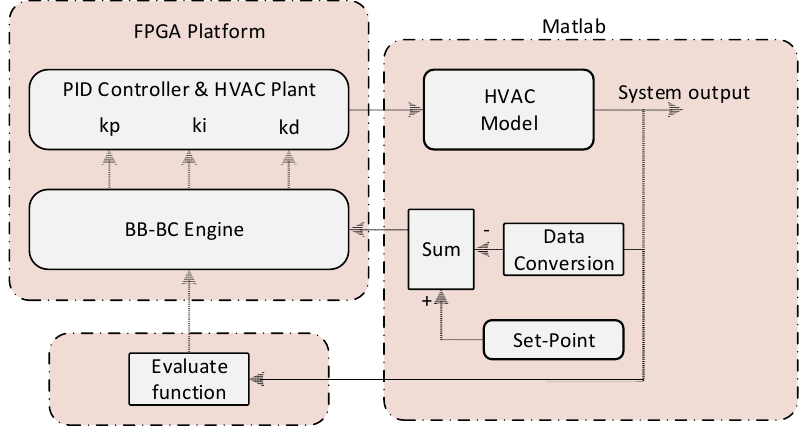
Figure 8. Proposed system architecture.